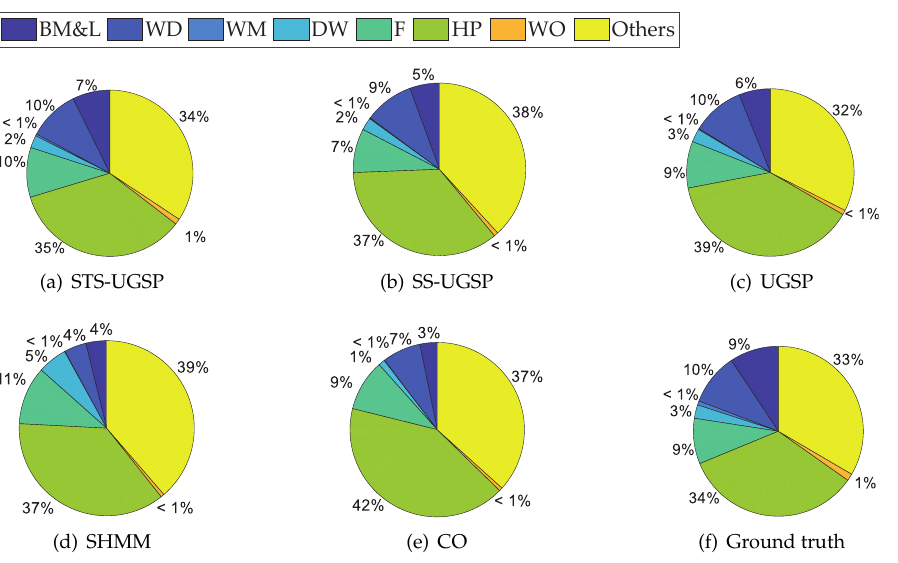
Figure 4. Pie charts of disaggregated energy shares on AMPds